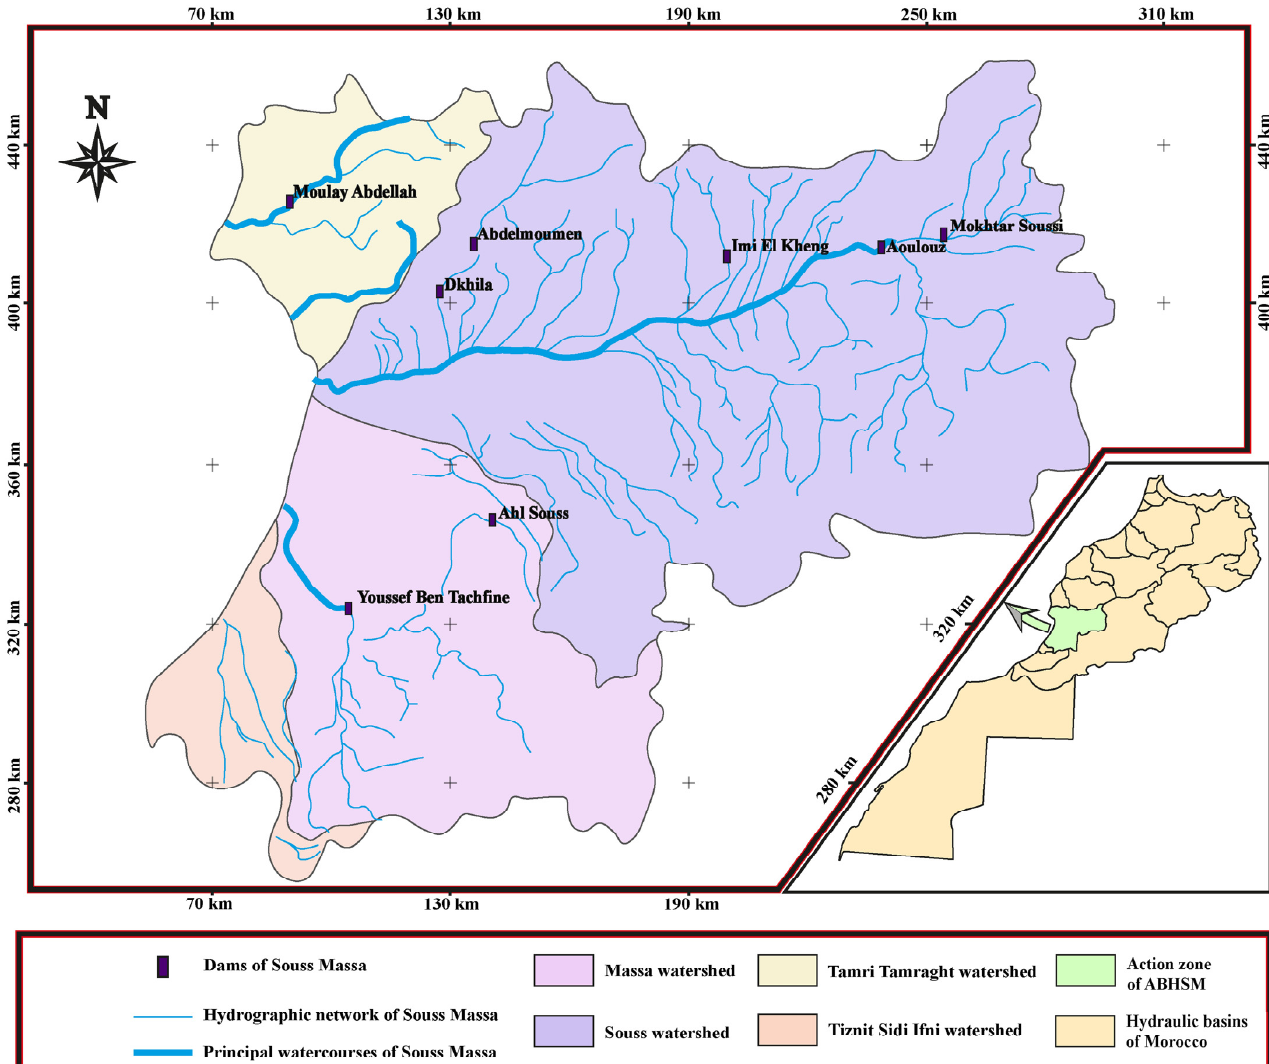
Figure 1. Hydrographic network and dams of Souss-Massa.